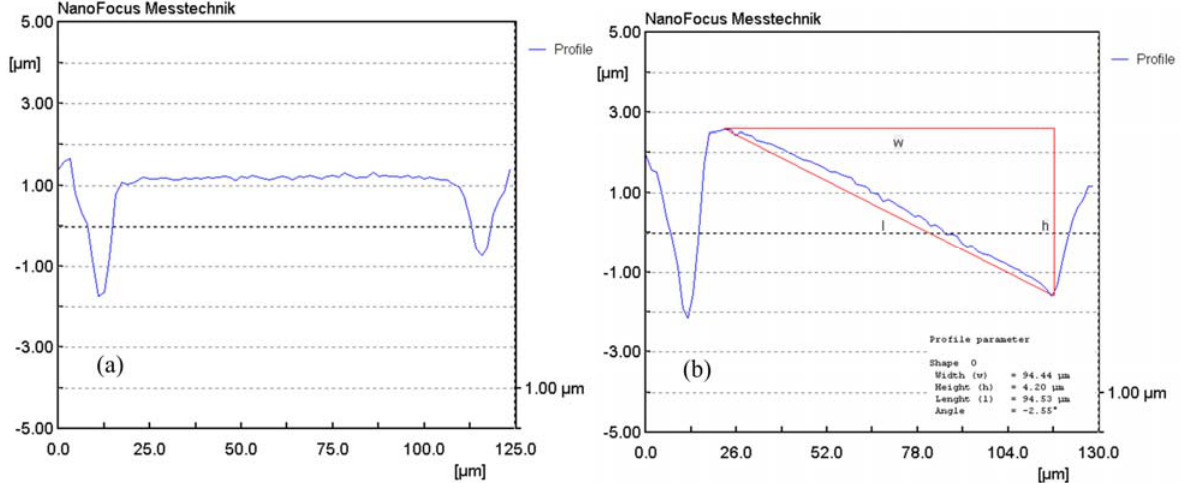
Figure 8. Profile of the micromirror (a) in the absence of a driving voltage and (b) under a driving voltage of 40 V, measured using a confocal surface optical scan